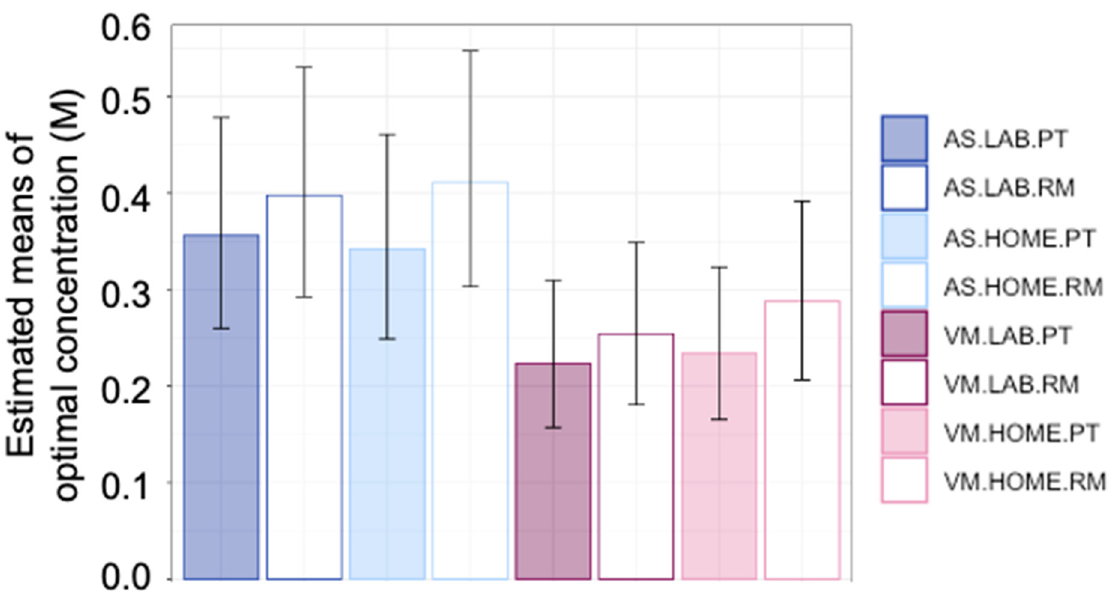
Figure 1. Optimal sucrose concentrations, averaged across replicate test sessions. Values are means estimated from a repeated-measures ANOVA on Box-Cox transformed sucrose concentrations, then back-transformed to the original units (M). AS = estimated using aqueous solutions; VM = estimated using vanilla milk; lab = test conducted in the laboratory; home = test conducted with participants tasting at home, supervised via video conferencing; PT = Preference Tracking, or optimal (most preferred) concentration estimated via paired-comparison preference tracking; RM = Rating Method, or optimal (most liked) concentration estimated from ratings of liking. For example, AS.LAB.PT is optimal concentration estimated using aqueous solutions, in the laboratory, via paired-comparison preference tracking. Error bars represent 95% confidence